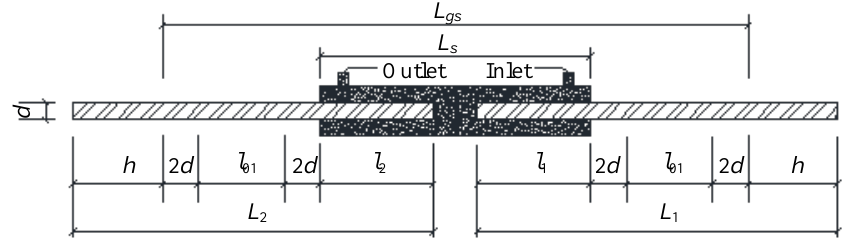
Figure 3. Defect model. ( a ) Preliminary defect model. ( b ) Defect model after Boolean operation.